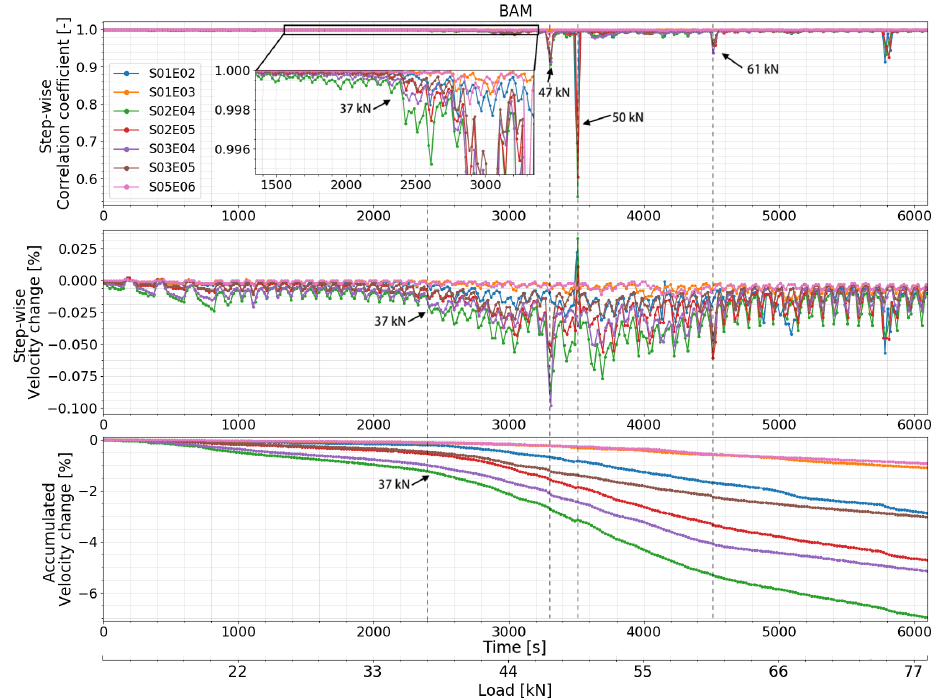
Figure 17. Correlation coefficient and relative velocity change of all the transducers combinations in test at BAM calculated by step-wise and accumulate